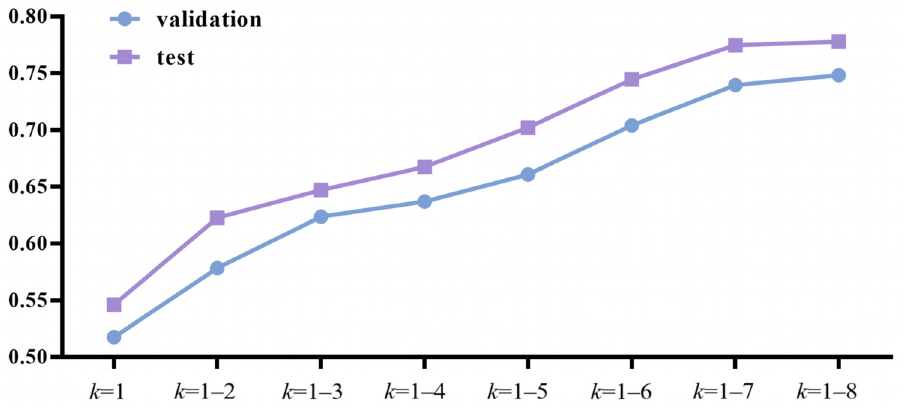
Figure 2. Accuracy with various k